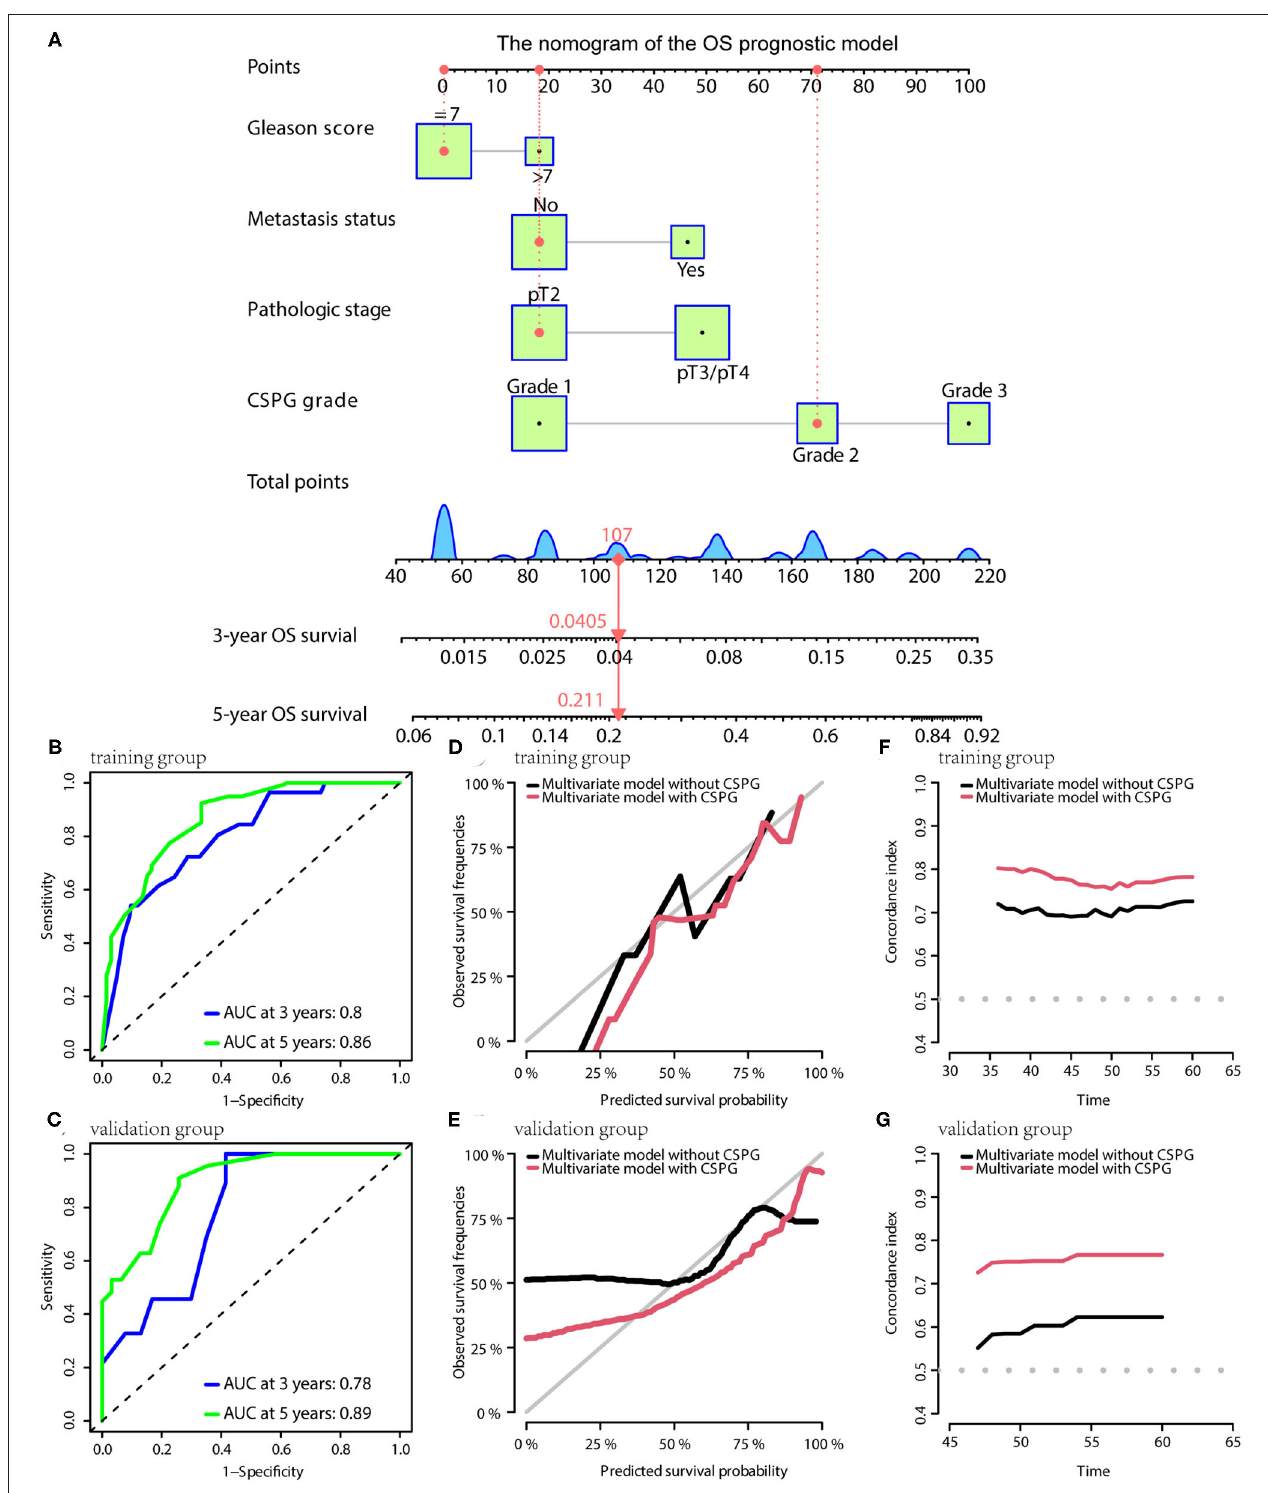
FIGURE 7 | The OS prognostic model possesses the accuracy and robustness. (A) Nomogram of the OS prognostic model with information of one patient as an example. Time-dependent receiver operating characteristic (tdROC) curves show the model has a good predictive accuracy at 3 and 5 years in the training group (B) and in the validation group (C) . The calibration curves indicate that the model using a combined cysteine rich secretory protein 3 (CRISP3) and serine peptidase inhibitor Kazal type 1 (SPINK1) prognostic grade (CSPG) predicts prognosis more accurately in the training group (D) and in the validation group (E) . The line chart shows the model using a CSPG has higher C-index values in the training group (F) and in the validation group (G) . OS, overall survival.